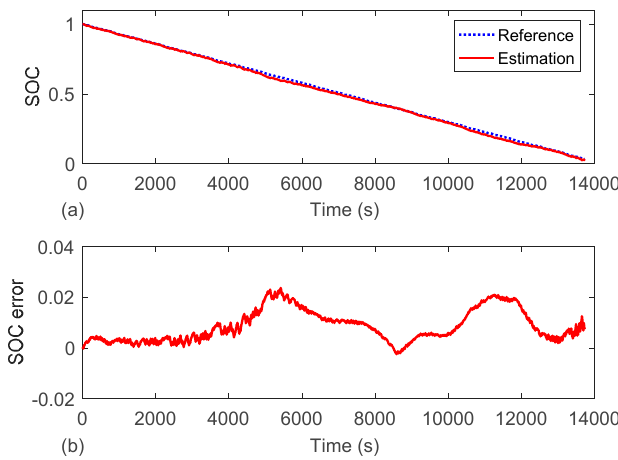
Figure 6. SOC estimation result under FUDS condition: ( a ) SOC; ( b ) SOC error.